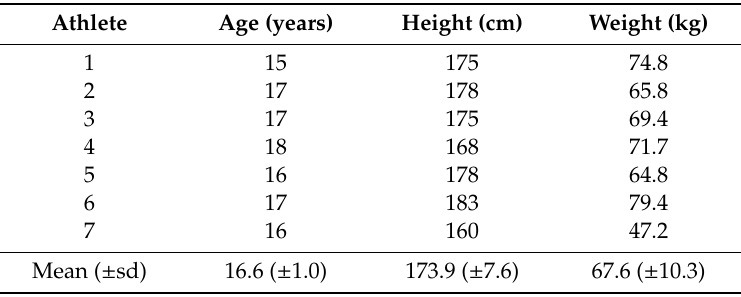
Table 1. Individual participant